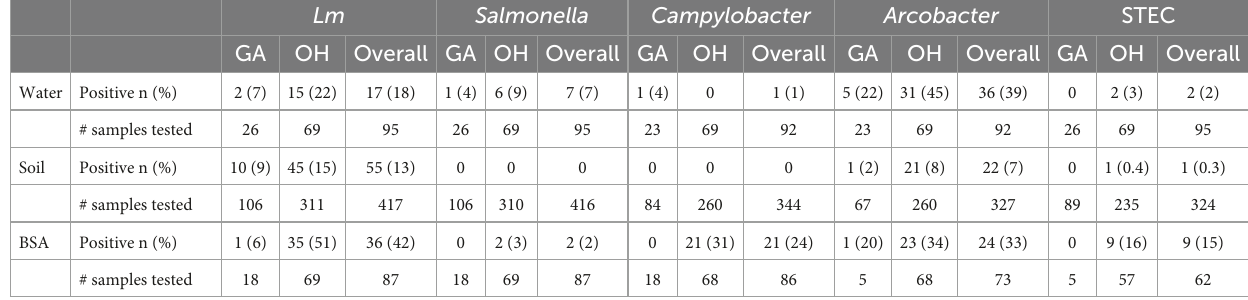
TABLE 1 Overall pathogen prevalence by sample type and state.